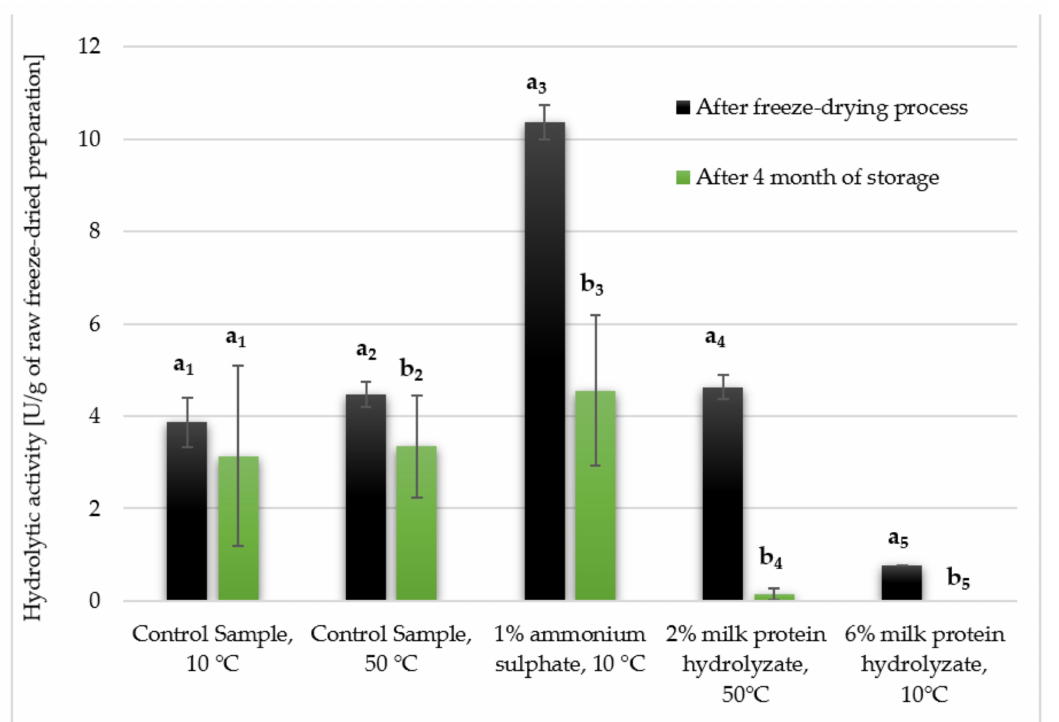
Figure 8. Hydrolytic activity of selected freeze-dried enzyme preparations after storage in a desiccator for 4 months (calcu- lated per 1 g of the preparation, referring only to the lyophilized supernatant, excluding the presence of the cryoprotectant). Significant differences are marked with letters and a number given in a subscript indicate the compared values. Experiments were performed in